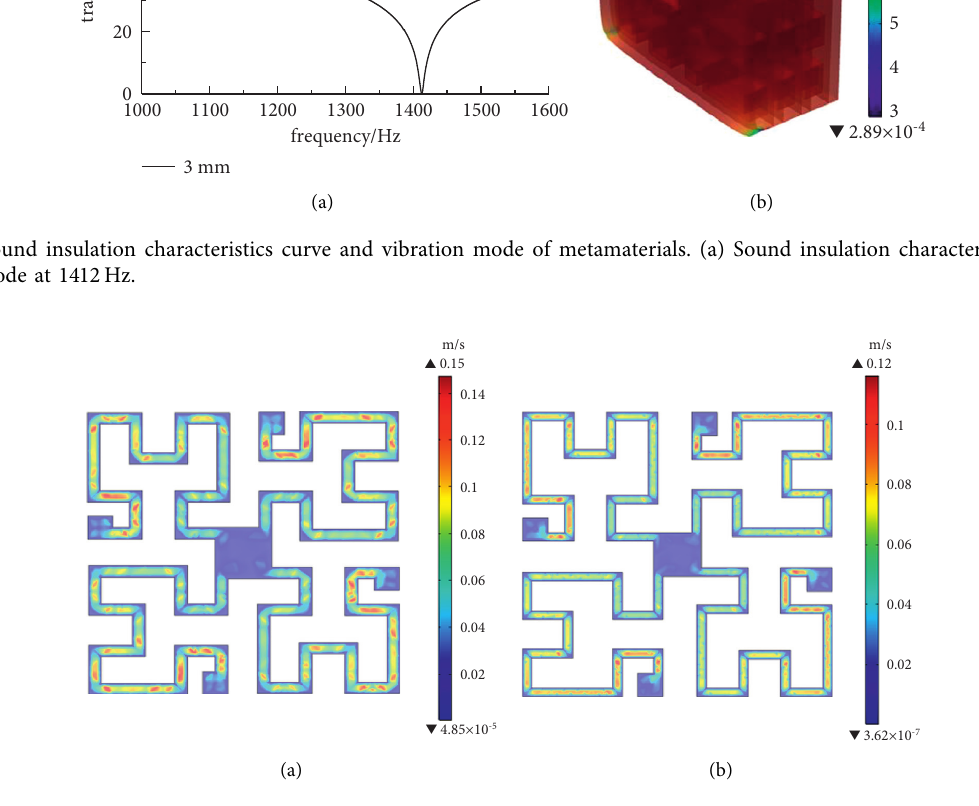
Figure 10: Centre plane particle velocity distributions of 4mm and 3mm metamaterials. (a) 4 mm particle velocity distribution. (b) 3mm particle velocity